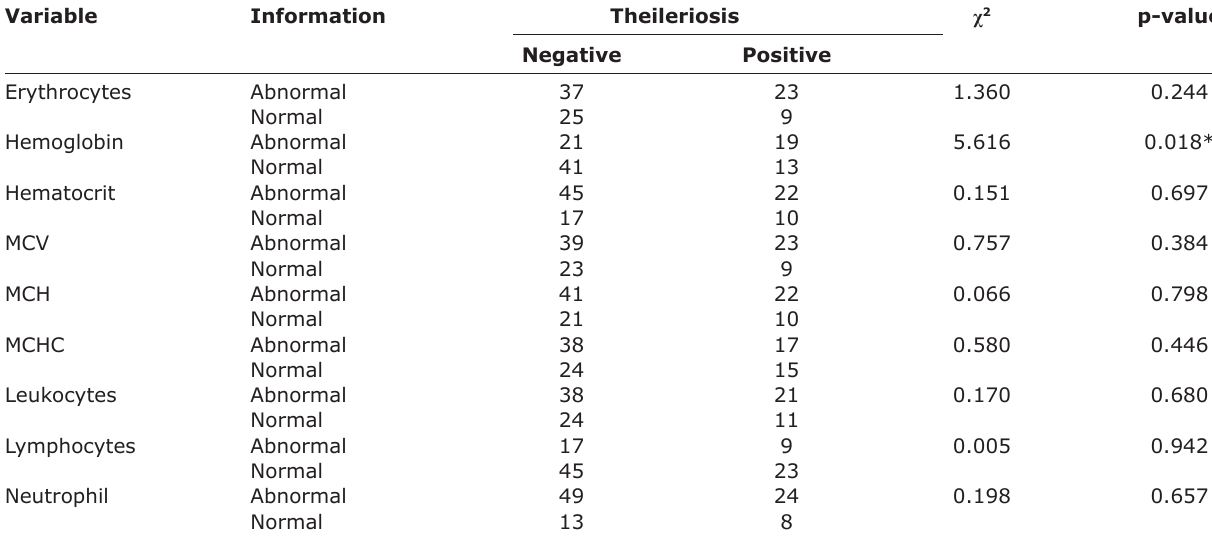
Table-1: Correlation between Bali cattle hematological profile variables and theileriosis. Variable